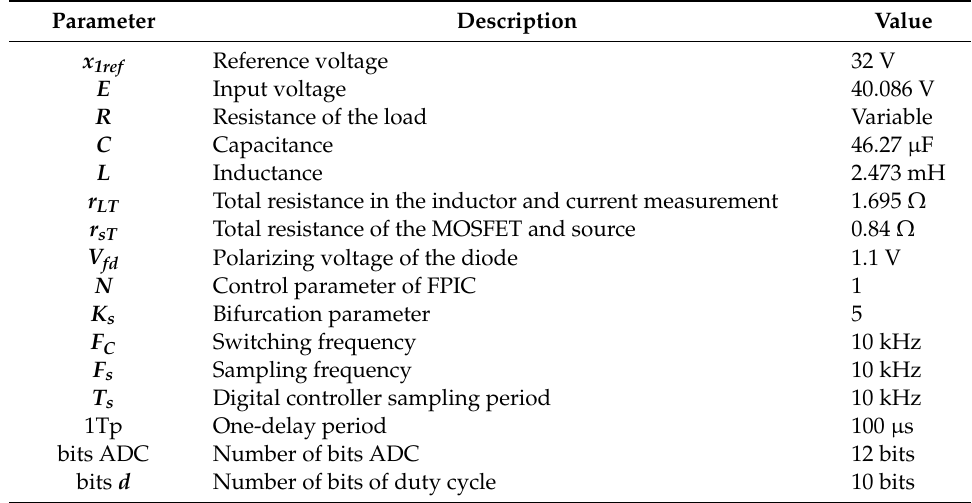
Figure 14. Simulation results to show the comparison of both controller when considering 𝑅 variations, 𝑅 = (cid:4670)30 ,150(cid:4671) Ω . Table 4. New parameters for the buck converter and the controller according to the loss estimation.